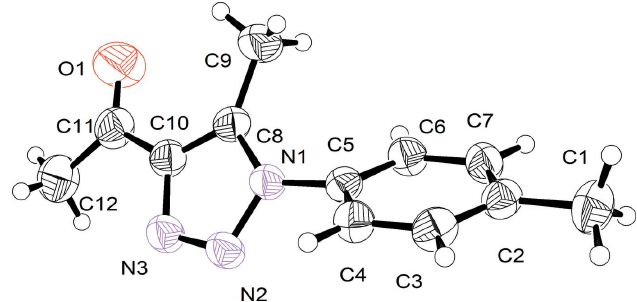
Figure 1 A view of the molecular structure of the title molecule, with the atom labelling. Displacement ellipsoids are drawn at the 50% probability level.